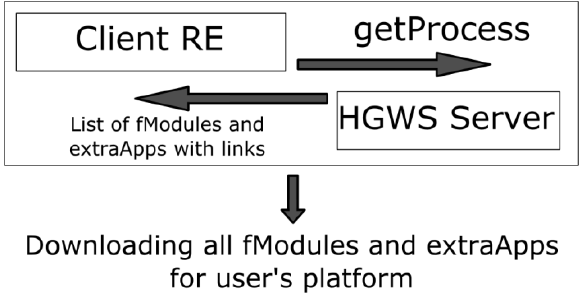
Figure 5. Third step of data exchange. Requesting process executable code and downloading program components with